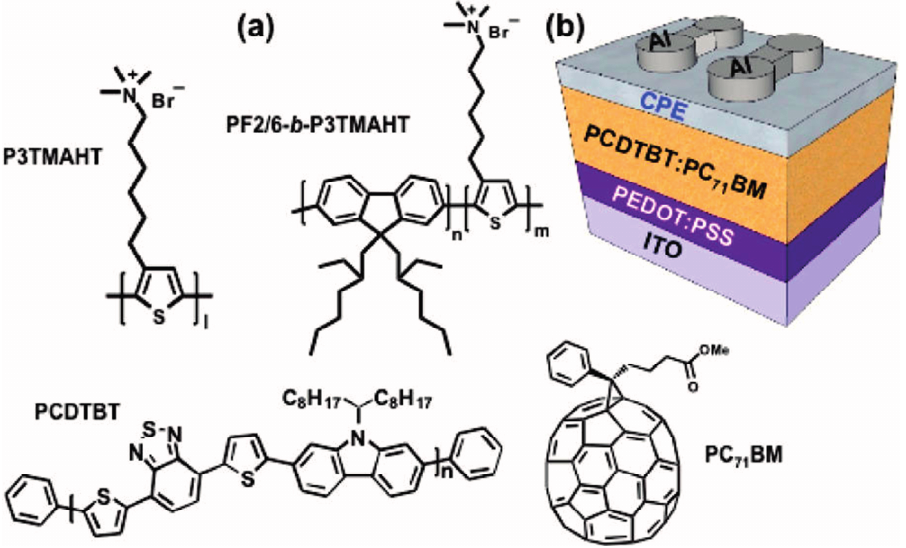
Figure 6. ( a ) Chemical structures of the materials used for polymer solar cells; ( b ) device configuration for the cells used in the study. In PF2/6- b -P3TMAHT, the average values of n and m were 16 and 27, respectively. Reprinted with permission from [68]. Copyright 2011 American Chemical